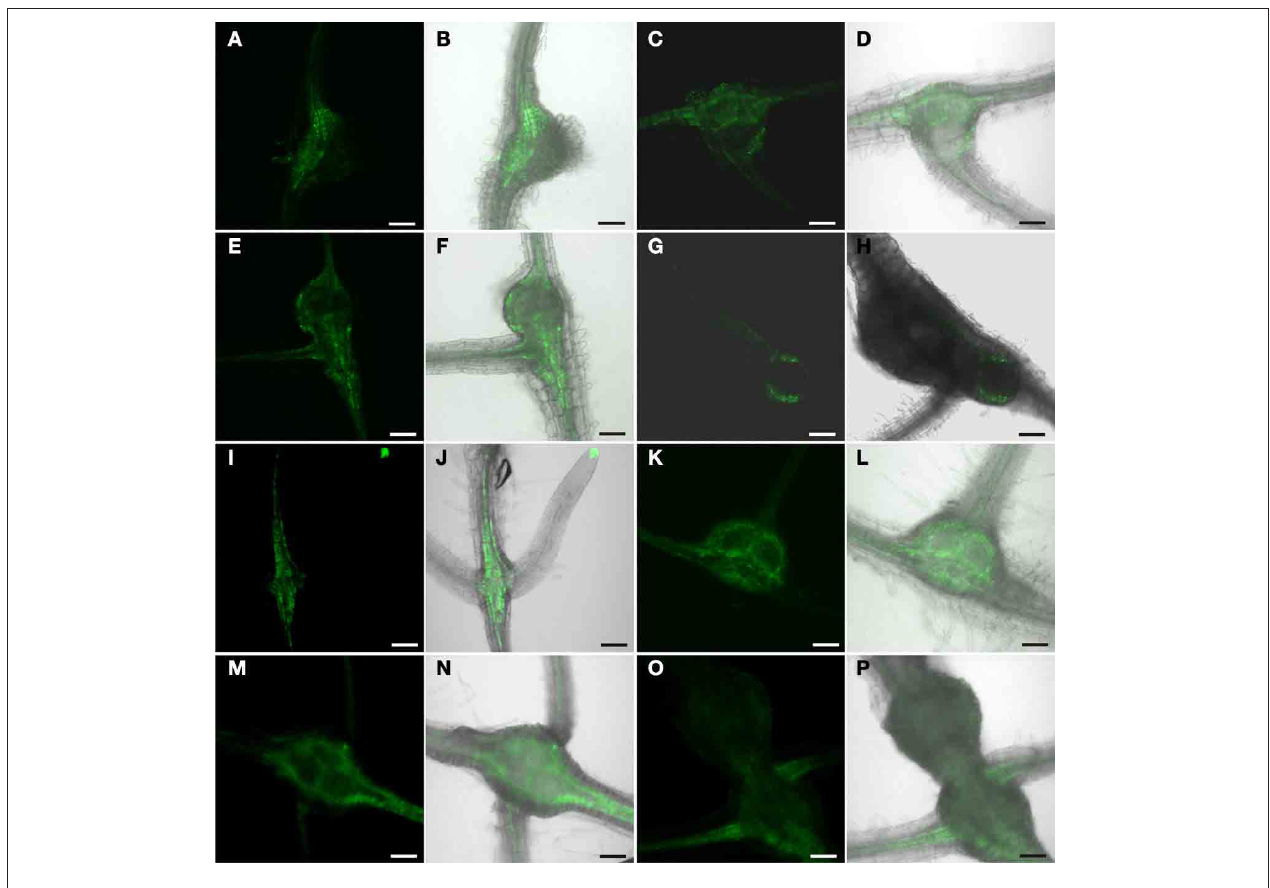
FIGURE 8 | GFP fluorescence in M. incognita -induced root knots of plants expressing ER-GFP under control of the DR5 promoter in a mutant background. (A – H) aux1 background, (I–P) axr1-3/axr4-2 background. Fluorescence is observed in auxin responsive tissues in a